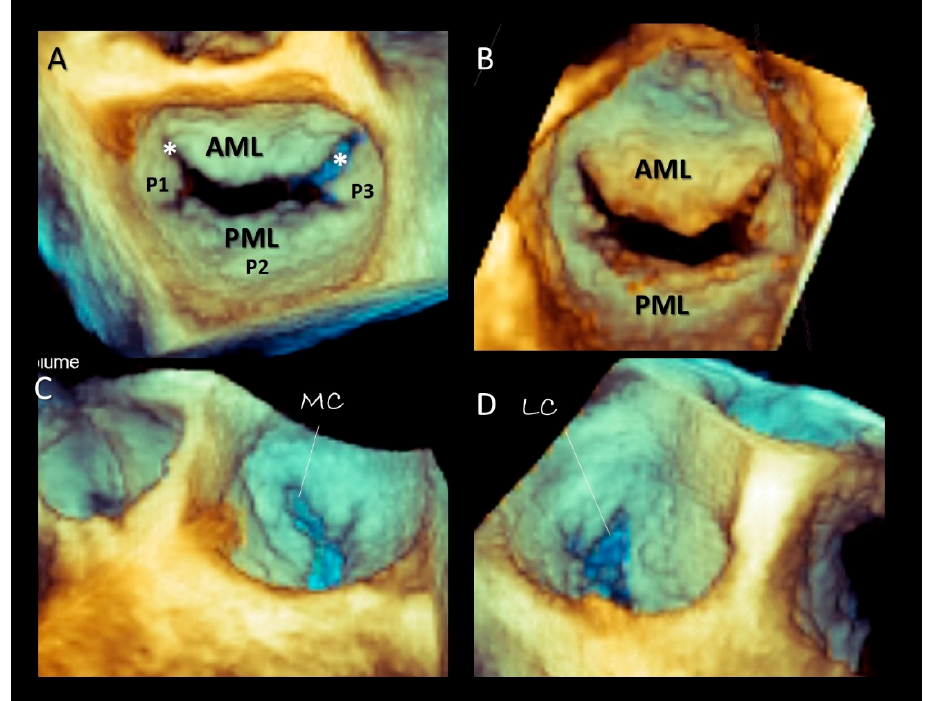
Figure 6. Three-dimensional TEE, the mitral valve four-basic view. ( A ) Surgical view. ( B ) View from left ventricle. ( C ) Angled lateral-to-medial view. ( D ) Angled medial-to-lateral view. AML = anterior mitral leaflet; PML = posterior mitral leaflet; MC = medial commissure (asterisk); LC = lateral commissure (asterisk).